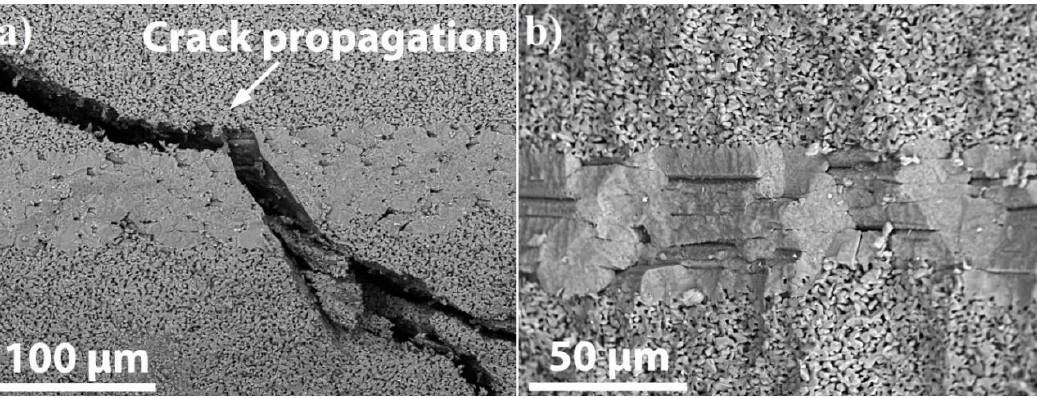
Figure 13. SEM images of fracture surfaces of the SiC f /SiC p composite: ( a ) crack propagation in the cross-sectional surface; ( b ) fracture surface.